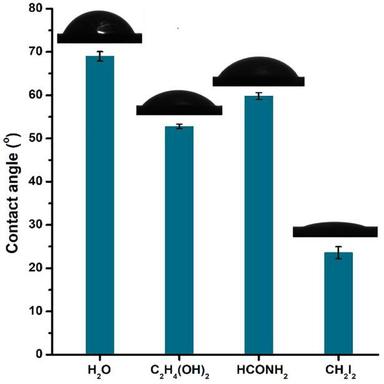
Contact angle of Bioflex® printouts with respect to various liquids.